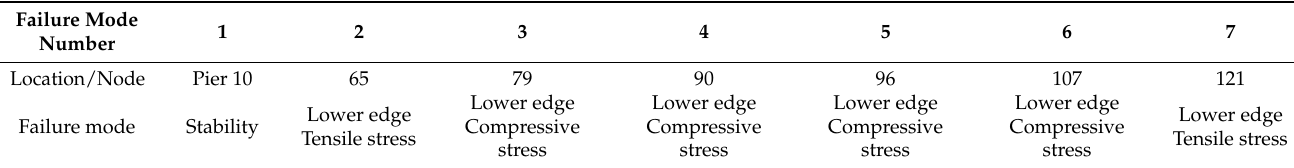
Table 2. Basic information of each failure mode.